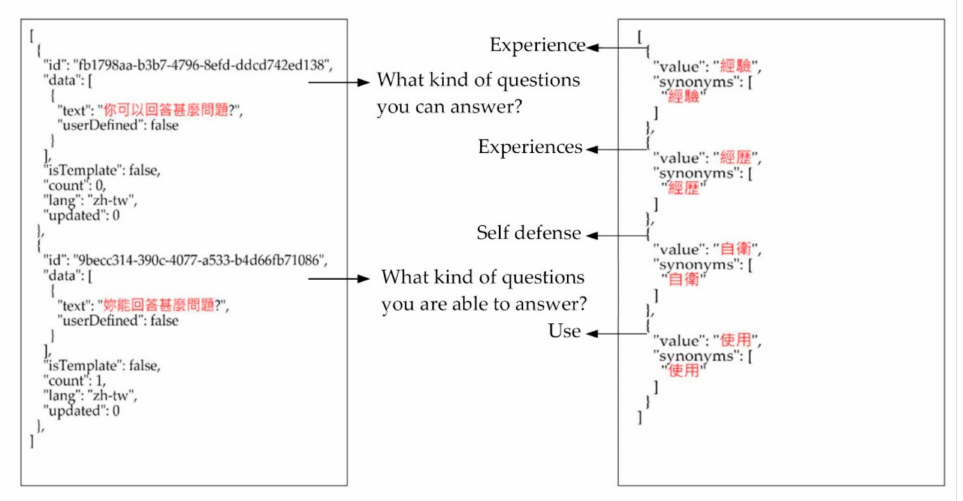
Figure 2. The syntax interfaces show how an intent and entity related to a specific userbot was built in the database. The left side interface shows that di ff erent sentence wordings with the same expression are built into the system; the interface on the right side shows entities of a sample question